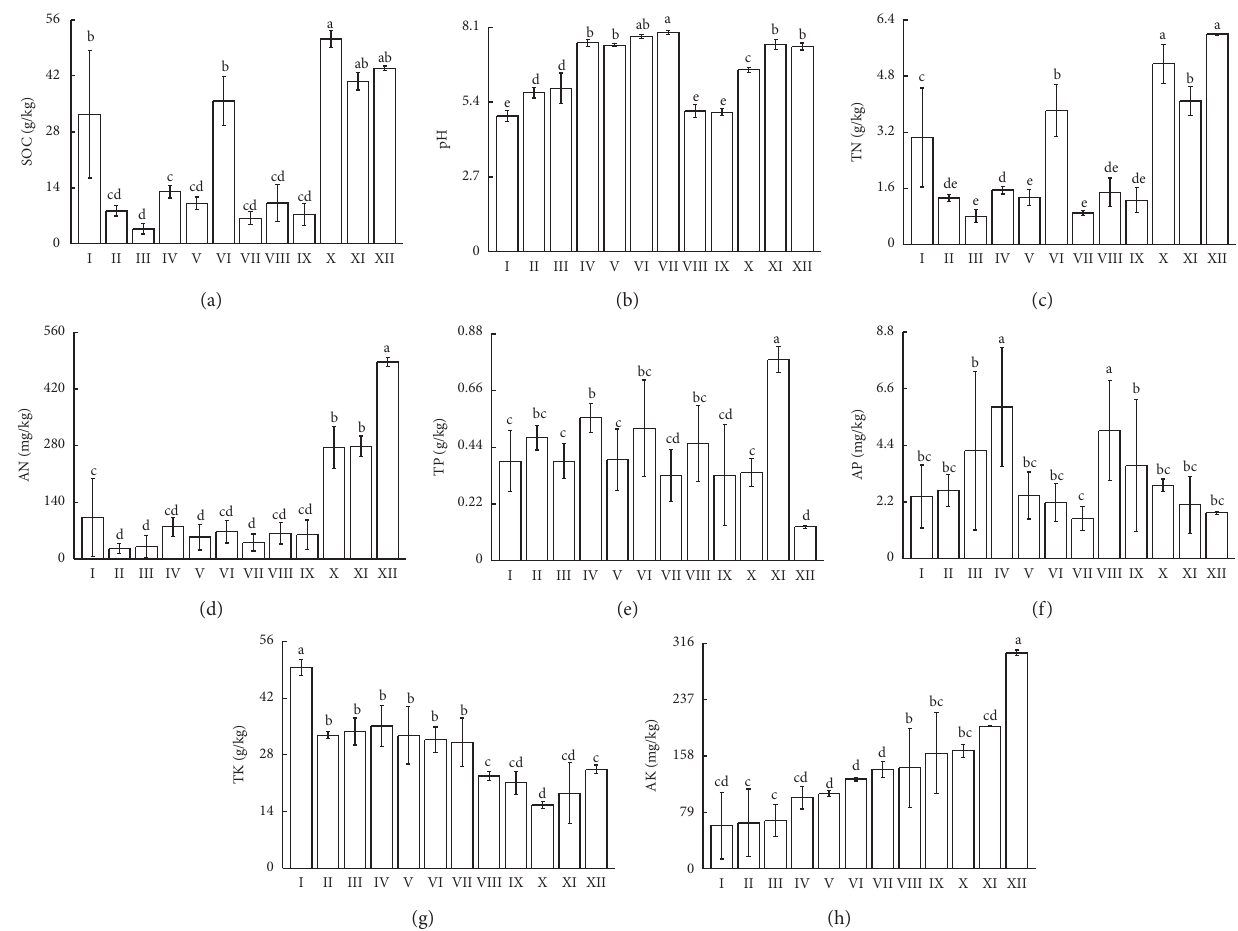
Figure 5: Soil pH and element contents under different land-use types. Note I, II, III, IV, V, VI, VII, VIII, IX, X, XI, and XII represent limestone shrubland, upper flue-cured tobacco field, lower flue-cured tobacco field, upper pear orchard, lower pear orchard, upper paddy field, lower paddy field, upper dryland, lower dryland, forest, grass slope, and dolomite shrubland, respectively. Different letters indicate significant differences in land-use